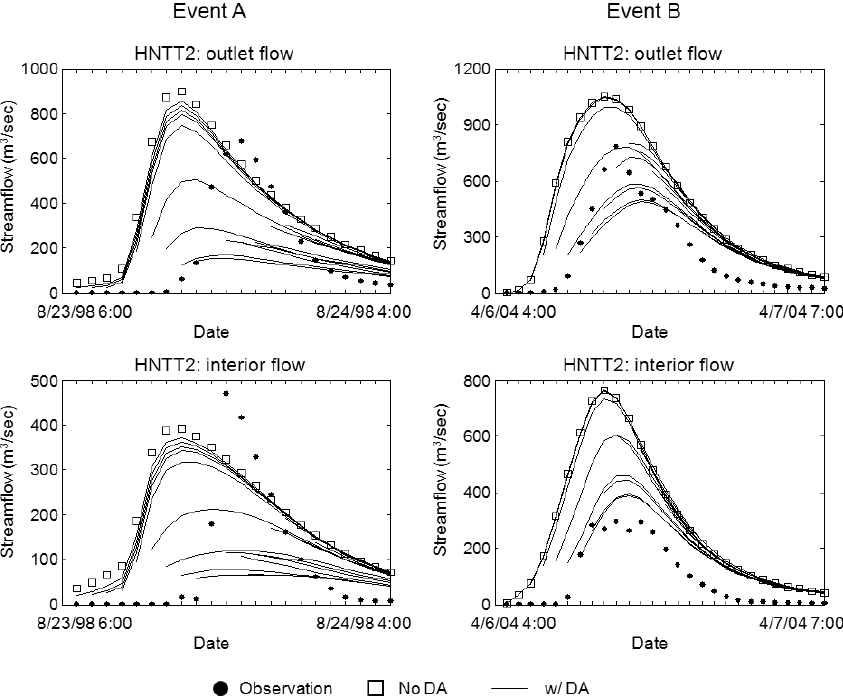
Fig. 13. Streamflow evaluated at the outlet and interior gauge locations for two events in HNTT2. The adjustment scale used is distributed and hourly. The data assimilated is outlet flow. Each curve represents analysis (at the prediction time) and prediction of hourly streamflow generated at different prediction time. 869 870 871